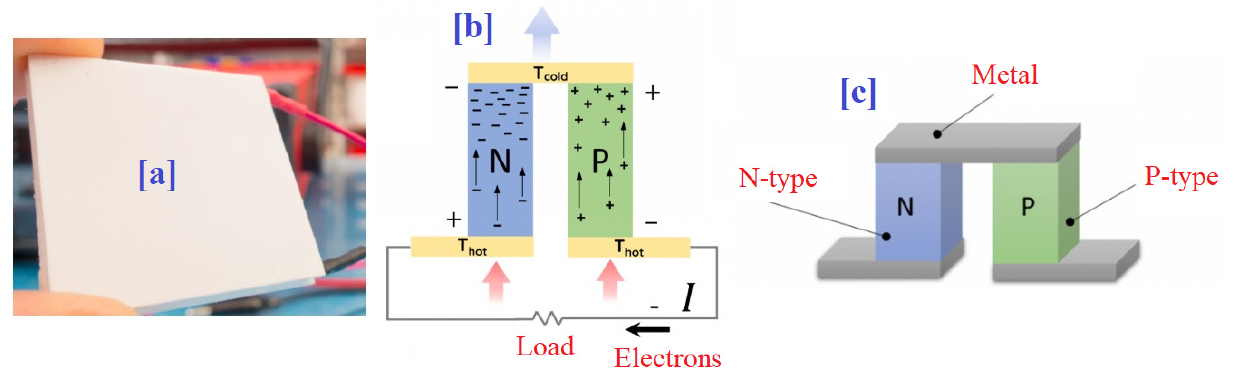
Figure 3. Construction of the TEG.